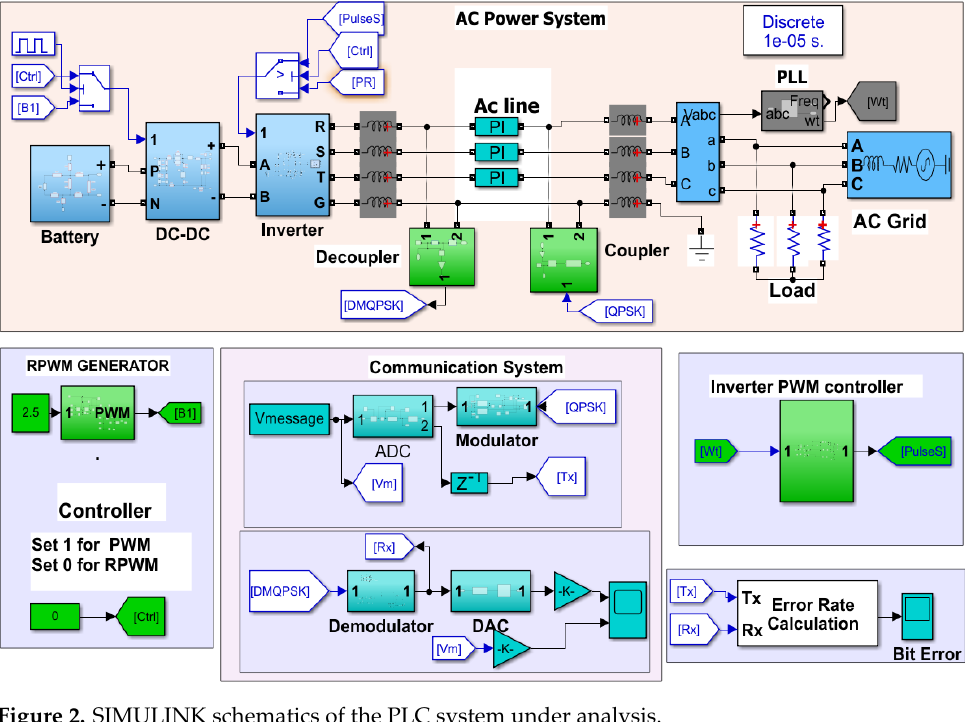
Figure 2. SIMULINK schematics of the PLC system under analysis.